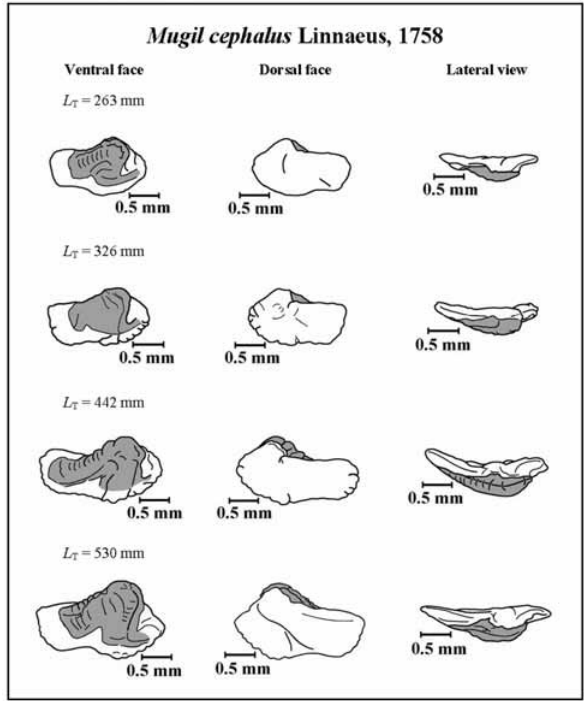
F IG . 14. – Three aspects of a right lapillus from Liza ramada F IG . 15. – Three aspects of a right lapillus from Mugil cephalus (Mugilidae) of four size classes. The shaded area corresponds to the (Mugilidae) of four size classes. The shaded area corresponds to the gibbus maculae in the ventral face and lateral view images and to gibbus maculae in the ventral face and lateral view images and to the regio apicale gibbi maculae in those of the dorsal face. The the regio apicale gibbi maculae in those of the dorsal face. The otoliths are represented with the lateral margin to the top of the page otoliths are represented with the lateral margin to the top of the page and the anterior region to the middle of the first two columns (ven- and the anterior region to the middle of the first two columns (ven- tral and dorsal faces), or with the dorsal face to the top of the page tral and dorsal faces), or with the dorsal face to the top of the page and the anterior region to the right (lateral view). and the anterior region to the right (lateral